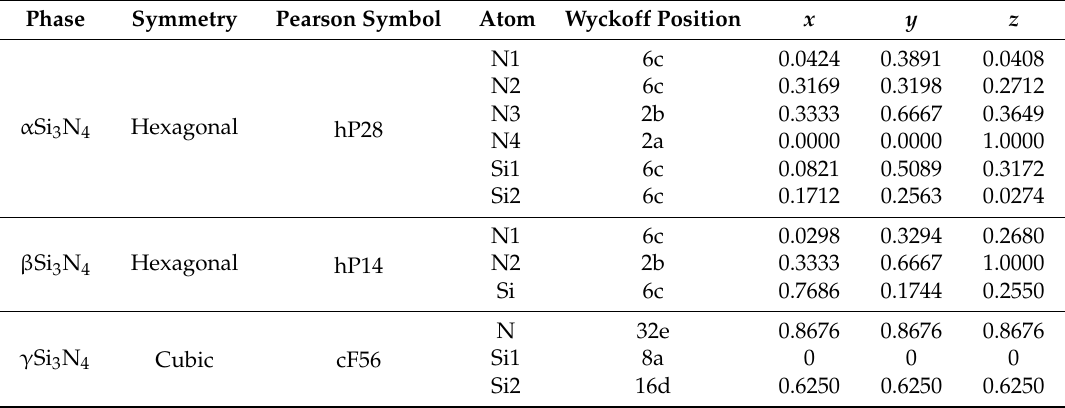
Table 12. Atom positions in the unit cell of Si 3 N 4